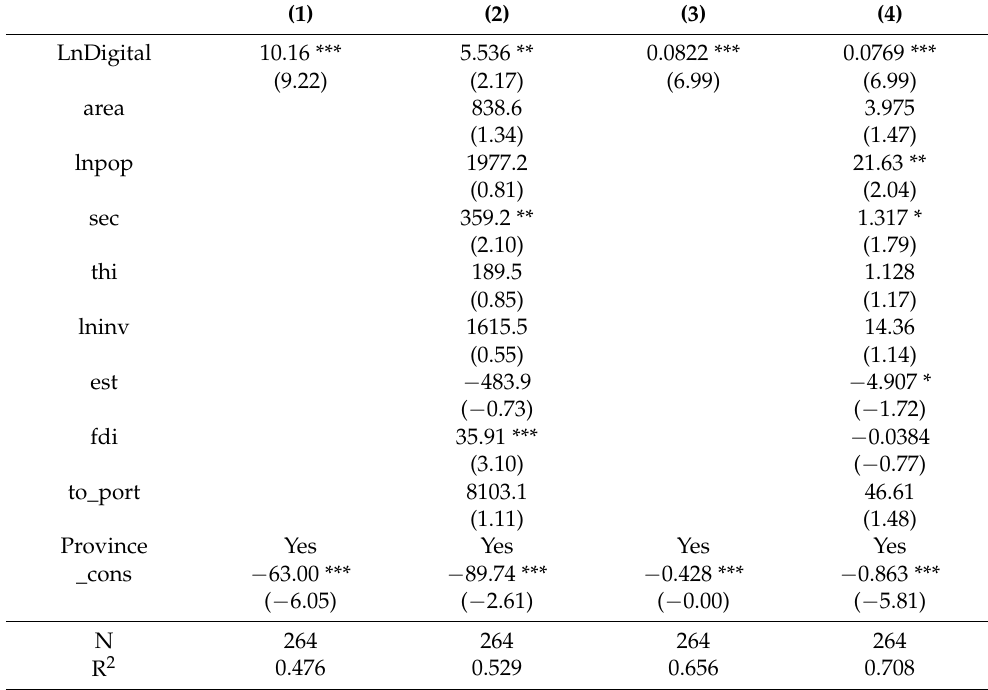
Table 11. Influence of Digital Economy on the Operational Status of Polluting